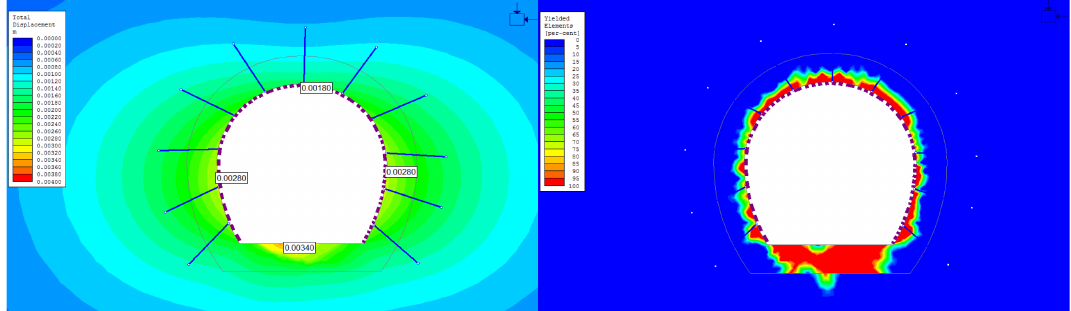
Figure 6. Load tunnel finite element analysis performed in Phase 2 R (cid:13) . The left image shows displacements and the right shows yield elements for a B-type rocky